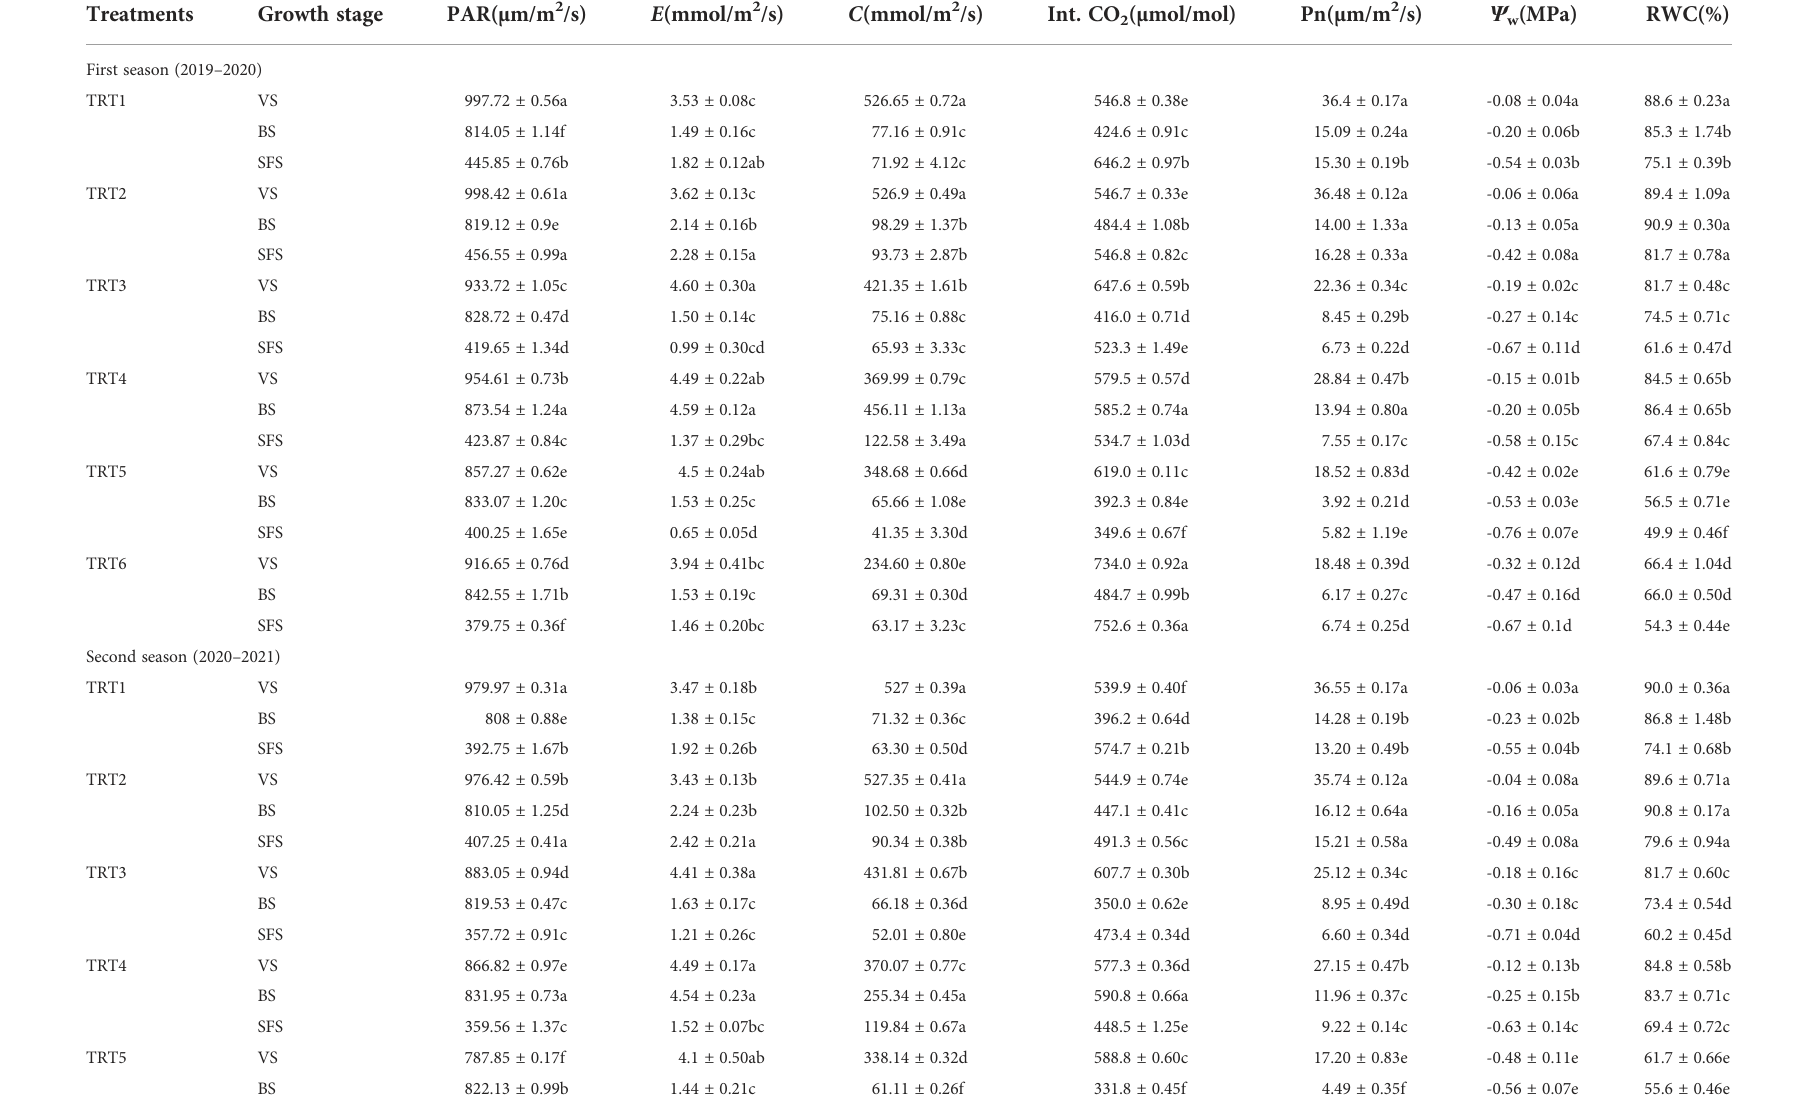
TABLE 1 Effect of different treatments on the gaseous exchange parameters of coriander at different stages under drought stress.